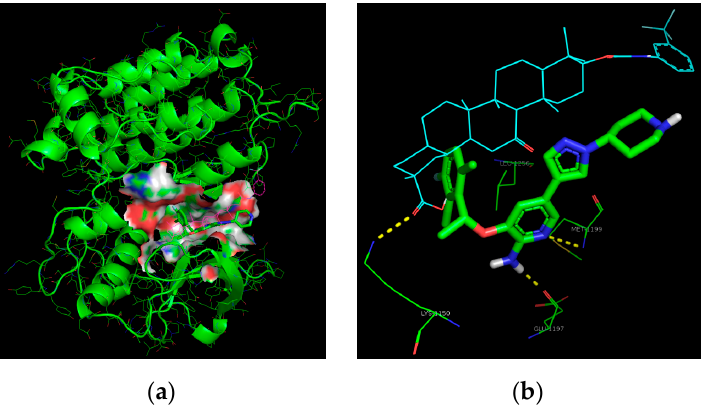
Figure 9. ( a ) Binding mode of Crizotinib (Stick) and the compound 3j (Line); ( b ) prediction of contacting residues in compound-protein interfaces. Hydrogen bonds are highlighted as yellow dashes.